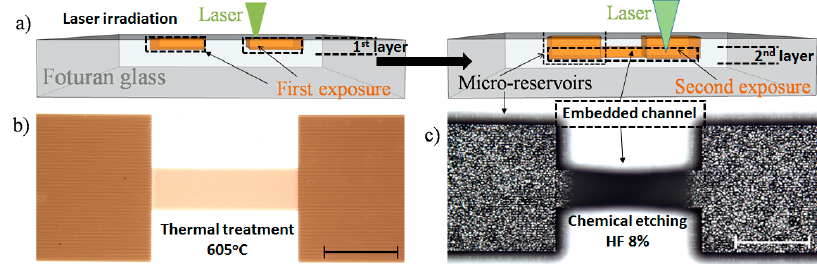
Figure 4. PLAE process of Foturan glass. ( a ) Sketch of the proposed design (with two open reservoirs connected by an embedded channel) and laser irradiation using two-layer configuration; and ( b , c ) partial view by optical microscopy of the obtained structure after irradiation with the VIS laser followed by ( b ) thermal treatment and ( c ) chemical etching in 8% HF solution. The scale bar represents 0.5